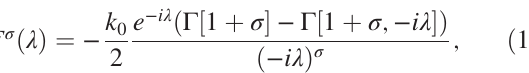
FIG. 3. The right part shows the absolute value of the transfer function for the coupling k new (red). The corresponding shapes of the electrodes are shown in the left part by the lines with the same colors. The half width of electrode at z ¼ 0 and the length l are assumed to be 15 mm and 0.3 m, respectively.